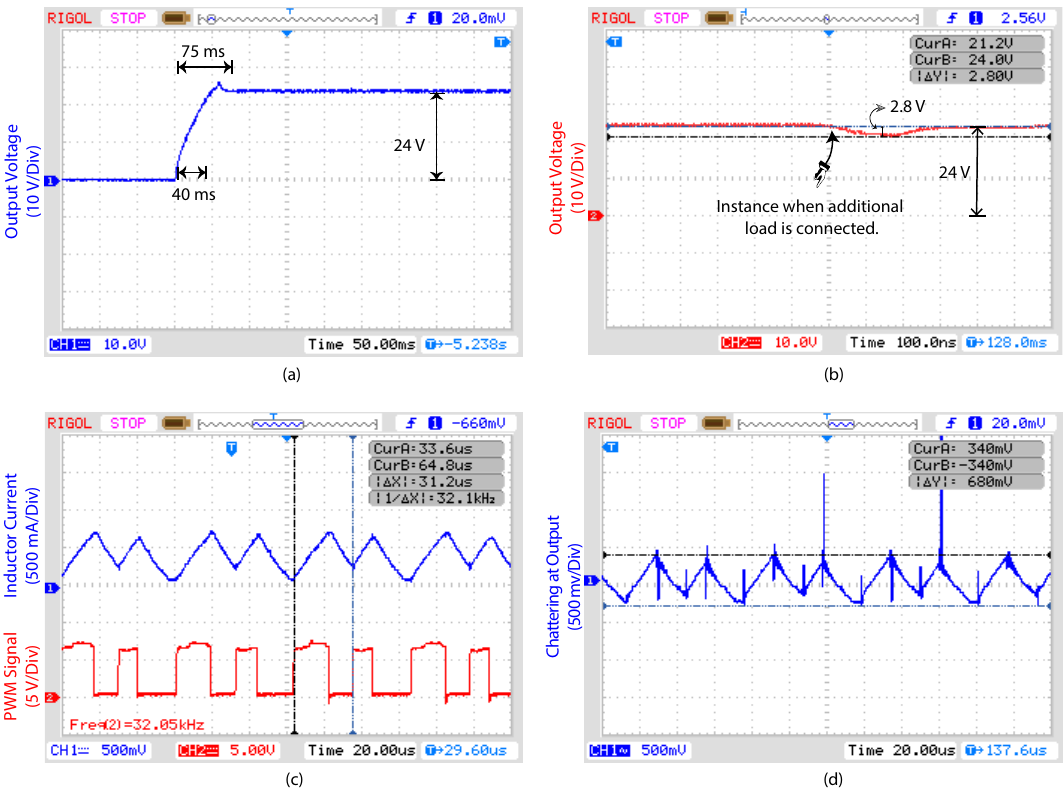
Figure 3. Experimental waveforms of the closed loop system with PWM-SMC. ( a ) Step response of the closed loop system. ( b ) Output voltage when load is shifted from 82 Ω to 29.88 Ω ( c ) Inductor current and gating signal at output of LM311 during steady state operation. ( d ) Chattering in the output